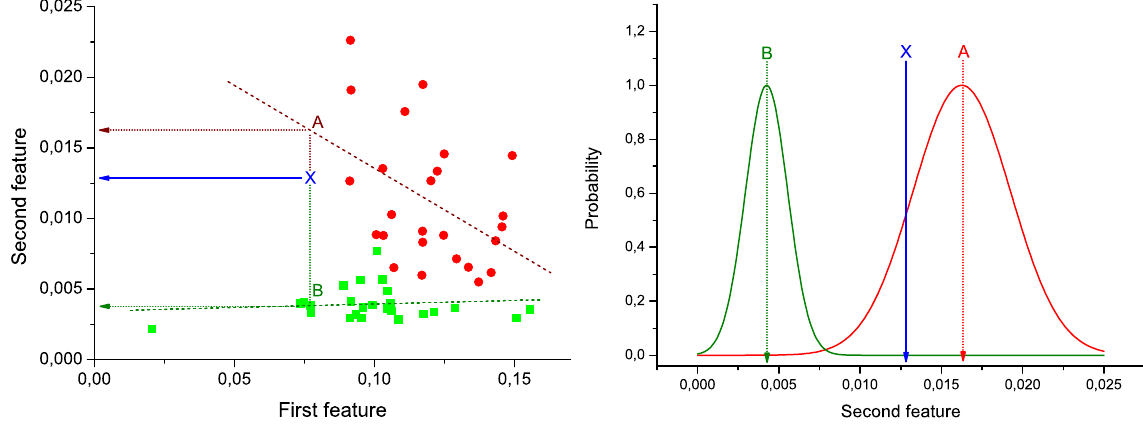
Figure 1. Example of calculation of the weight of a link. (Left) Lineal fit of data corresponding to control subjects and patients; (right) classification of an unlabeled subject (marked as X ) into one of the two